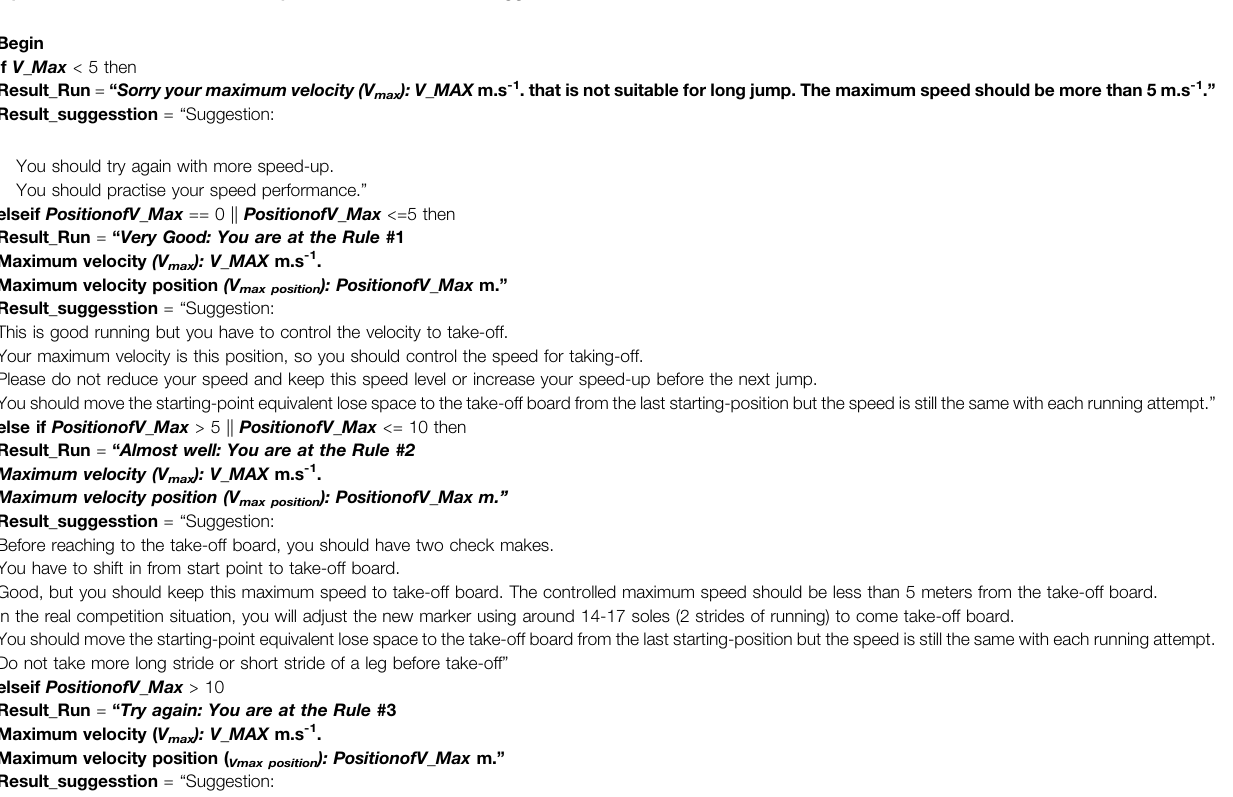
Algorithm 1 Approach-run suggestion